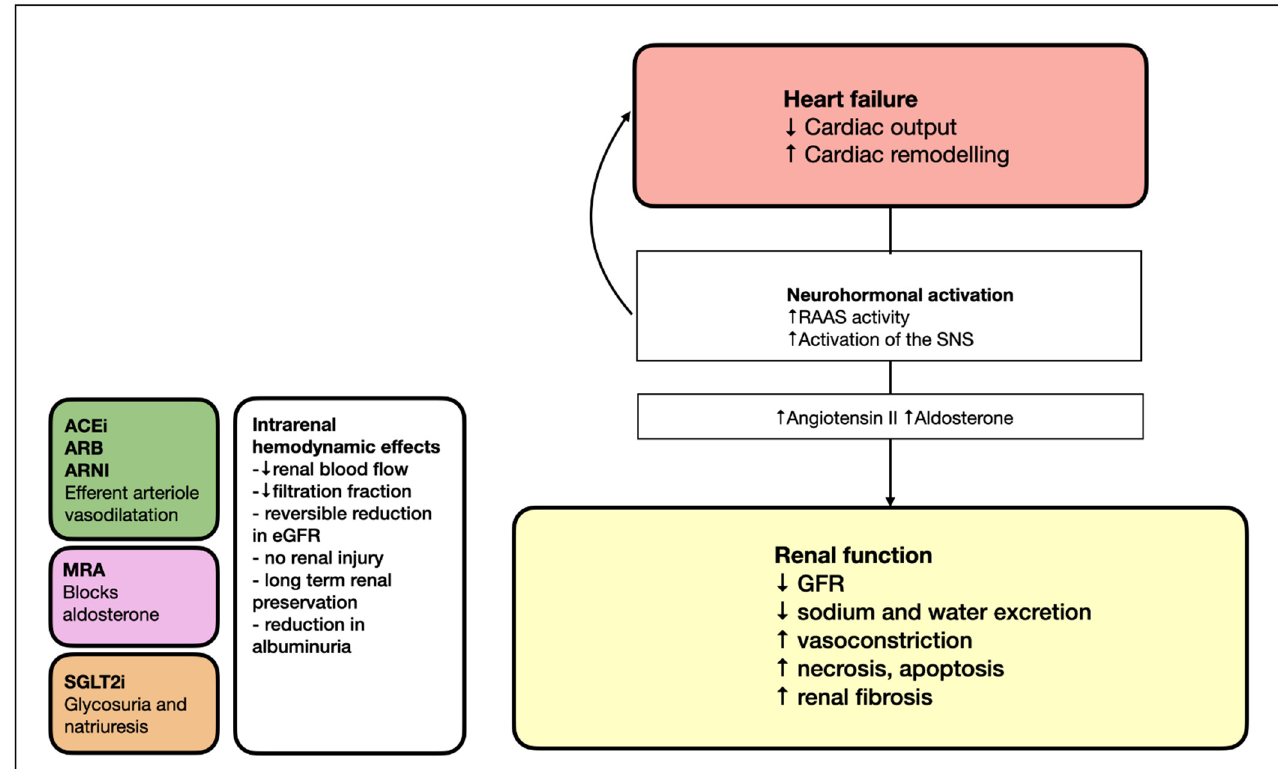
Figure 1. Mechanisms of heart failure and evidence-based treatments for renal function in HFrEF. ACEi, angiotensin-converting enzyme inhibitor; ARB, angiotensin II receptor blocker; ARNI, angi- otensin receptor blocker–neprilysin inhibitor; GFR, estimated glomerular filtration rate; MRA, min- eralocorticoid receptor antagonist; RAAS, renin–angiotensin–aldosterone system; SGLT2i, sodium– glucose cotransporter-2 inhibitor; SNS, sympathetic nervous system. Table 1. Recommendation of drug dosing in HFrEF in patients without and with CKD, based on available evidence and the SWISS medicinal product licensing body (SWISSMEDIC).